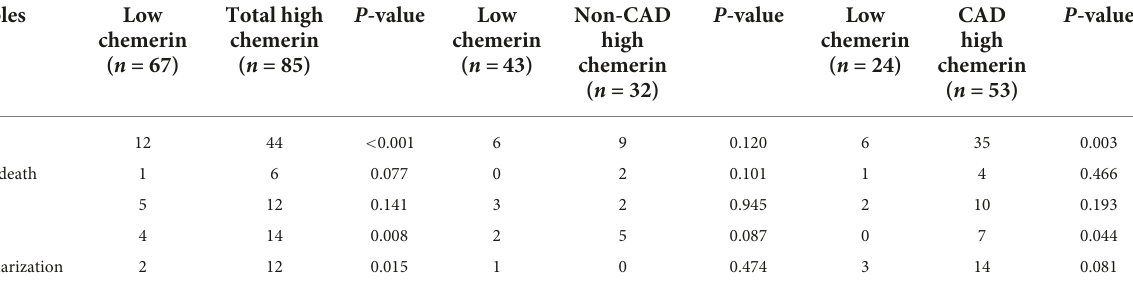
TABLE 2 Comparison of MACEs among high/low chemerin